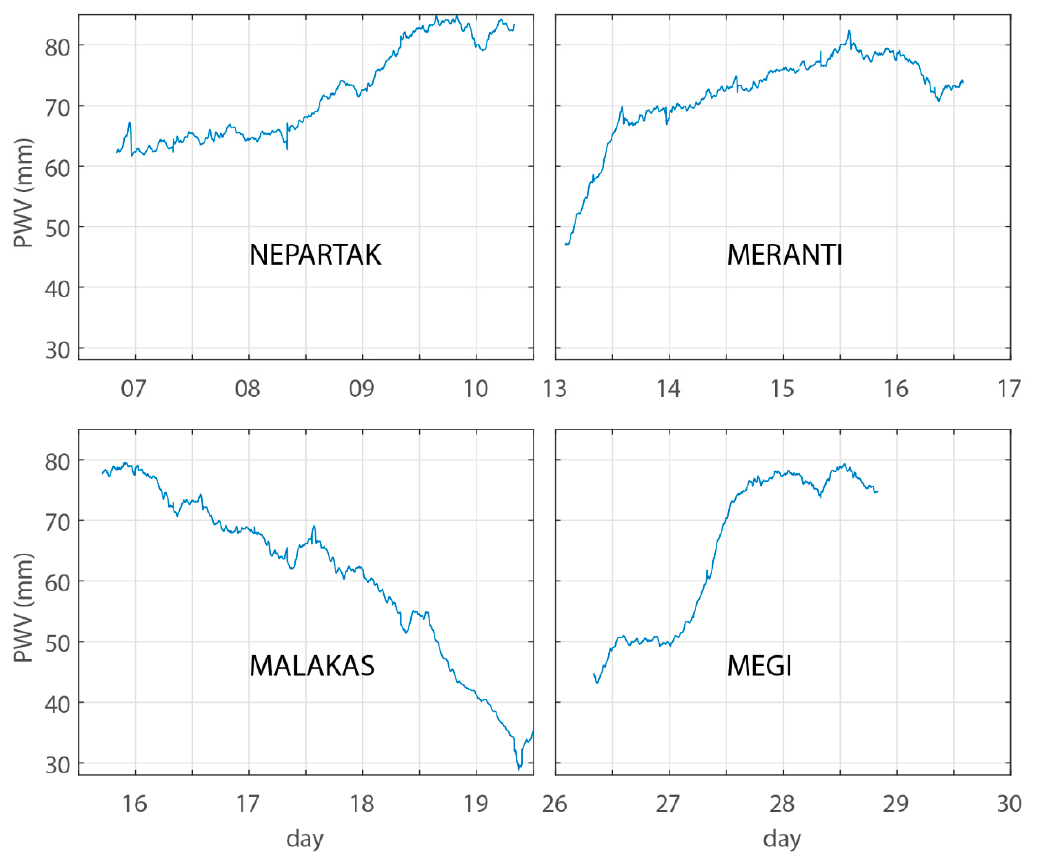
Figure 10. The average PWV over Zhejiang province during NEPARTAK, MERANTI, MALAKAS,